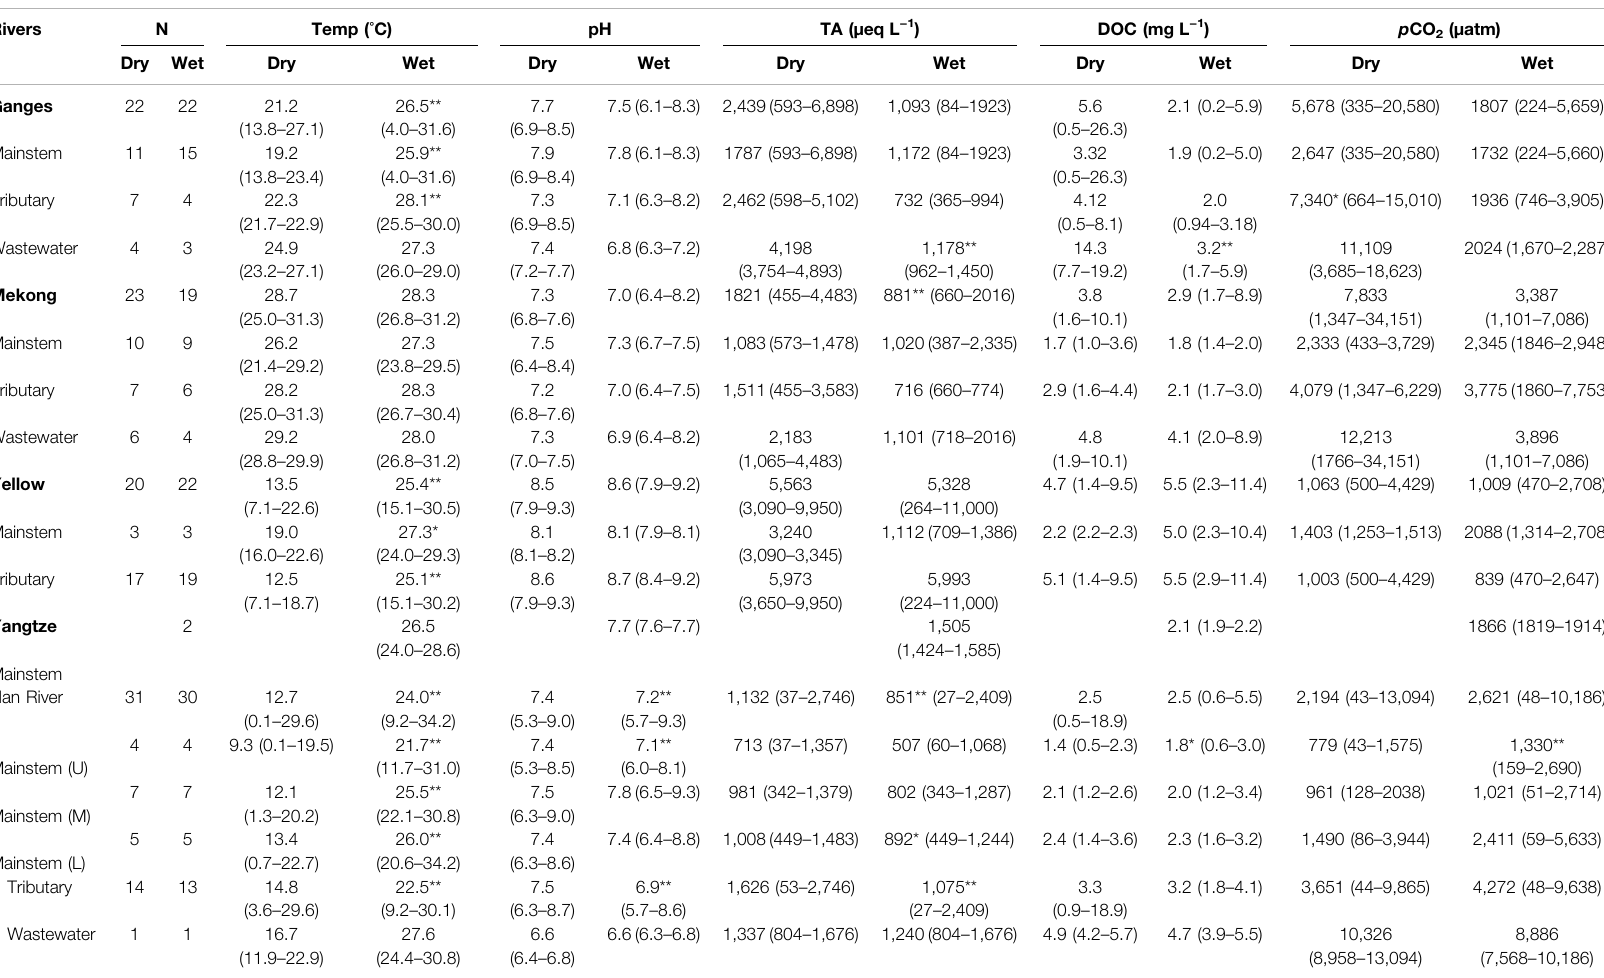
TABLE 2 | Comparison of water temperature (Temp), pH, total alkalinity (TA), dissolved organic carbon (DOC), and partial pressure of CO 2 ( p CO 2 ) measured in fi ve river systems in Asia between monsoon (wet) and dry season. Values are means followed by ranges in parentheses. N represents the number of the study sites.